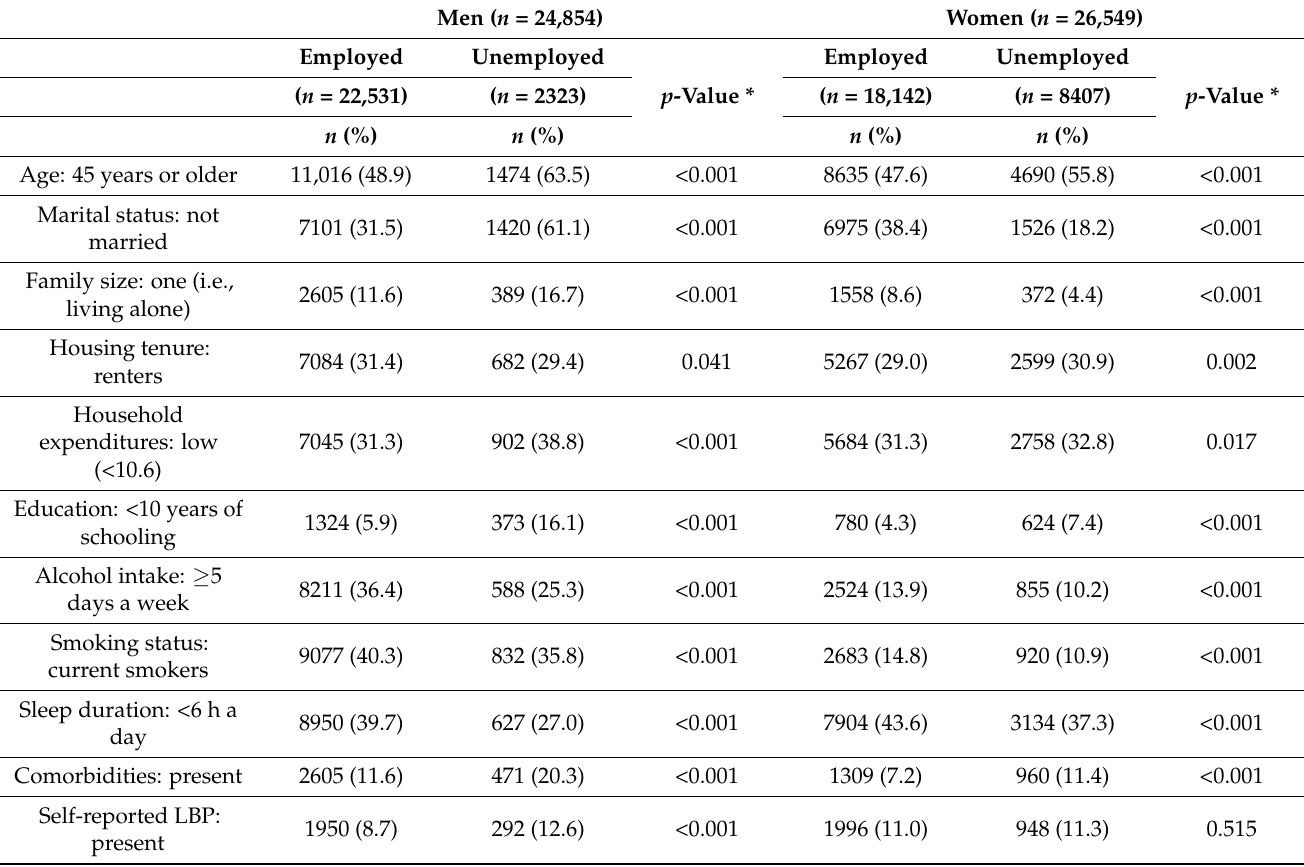
Table 1. Participant characteristics according to employment status (employed or unemployed), by gender. Men ( n = 24,854)